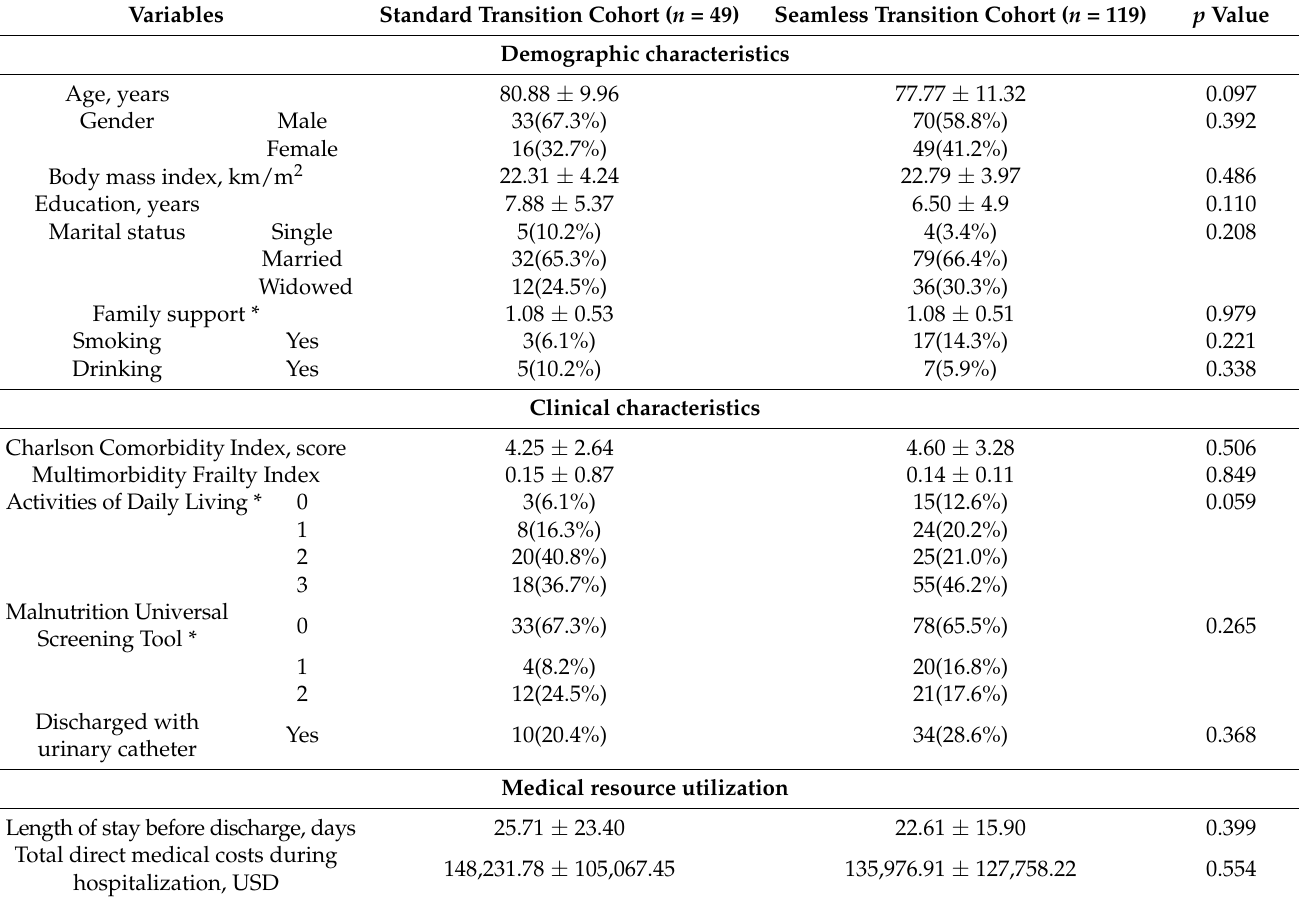
Table 1. Comparison of patient characteristics between standard transition cohort and seamless transition cohort ( n = 168).